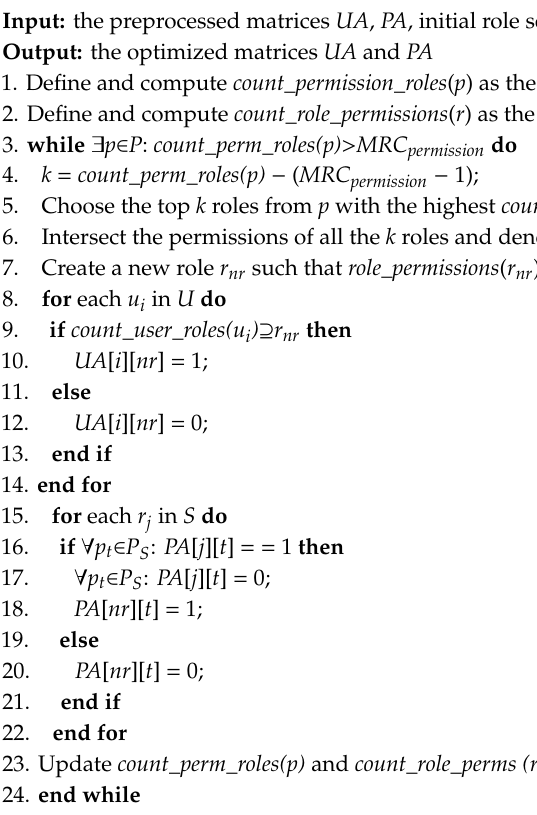
Algorithm 5. Role optimization satisfying